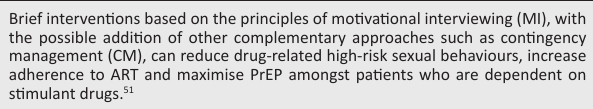
BOX 11: Motivational interviewing and adherence.